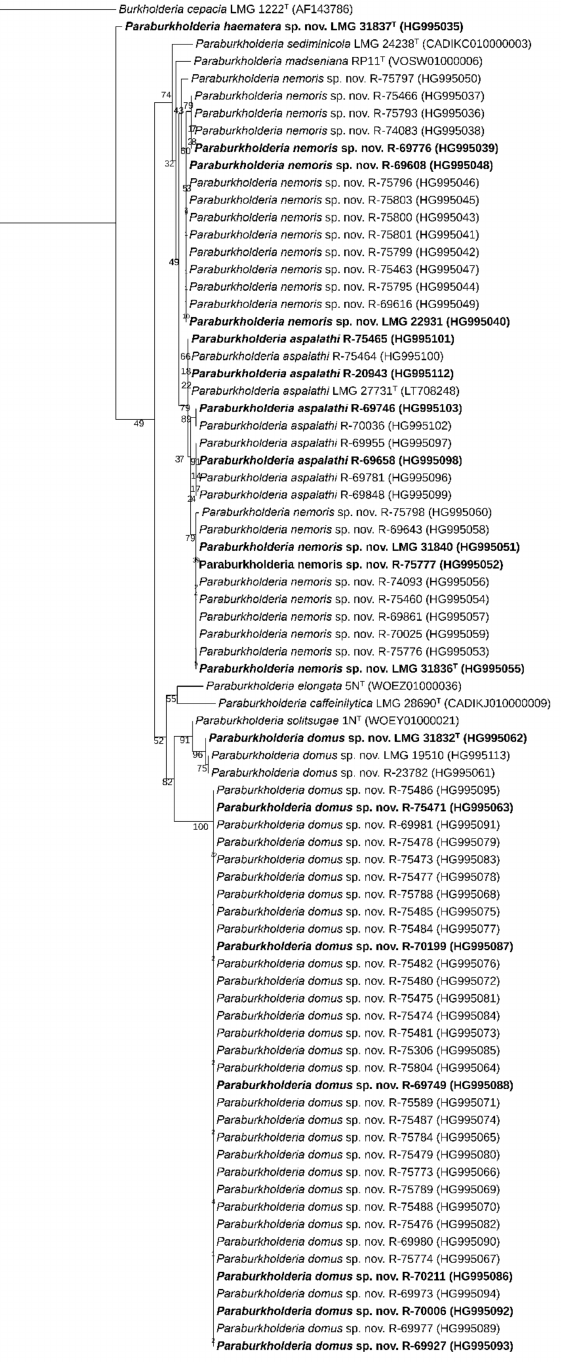
Figure 1. Phylogenetic tree based on recA gene sequences. Sequences (633–1074 bp) were aligned based on their amino acid sequences and phylogeny was inferred using the Maximum Likelihood method and GTRGAMMA substitution model in RAxML. The percentage of trees in which the associated taxa clustered together (1000 bootstrap replicates) is shown next to the branches. Burkholderia cepacia LMG 1222 T was used as outgroup. The scale bar indicates the number of substitutions per site. Isolates in bold character type were selected for whole genome sequence analysis. Sequence accession numbers are shown in